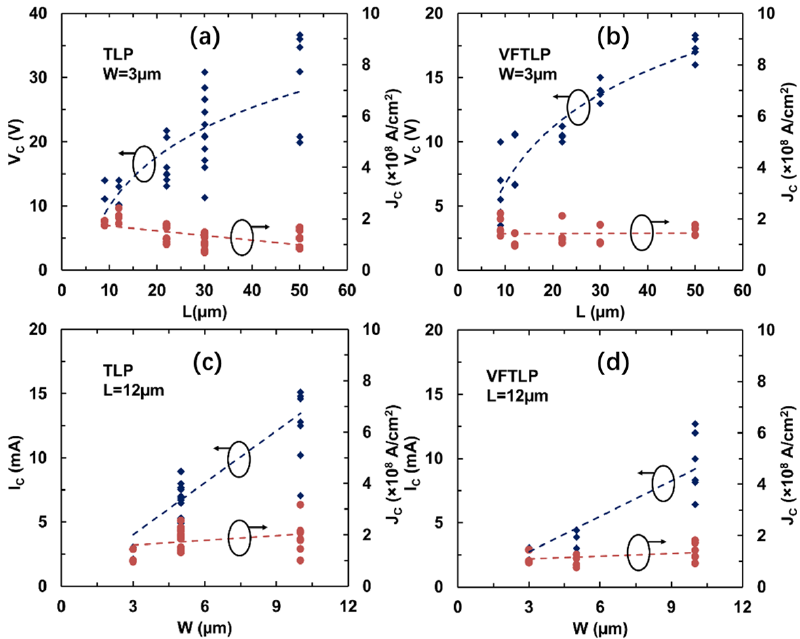
Figure 19. Statistics for measured V C and J C versus L and W for GR wires: ( a ) TLP for W = 3 µm; ( b ) VFTLP for W = 3 µm; ( c ) TLP for L = 12 µm; ( d ) VFTLP for L = 12 µm.